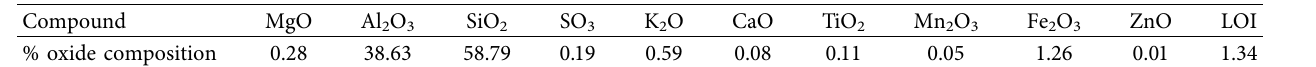
Figure 2: Flow chart of the GEP algorithm [22]. Table 1: Chemical composition of metakaolin (%).